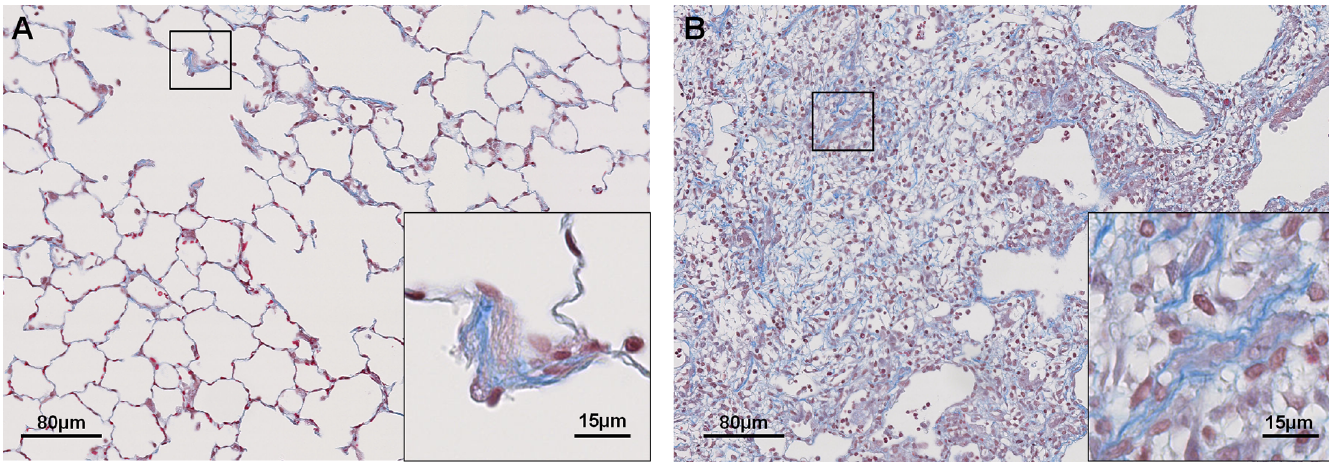
Fig 1. Fibrosis features used for morphometric detection. Digitalized slides of Masson’s tri-chrome stained lung paraffin sections. Collagen is stained in blue and cell nuclei in red. A : alveolar thickening by collagen deposition. B : fibrotic masses composed of collagen, fibroblasts, and other components.